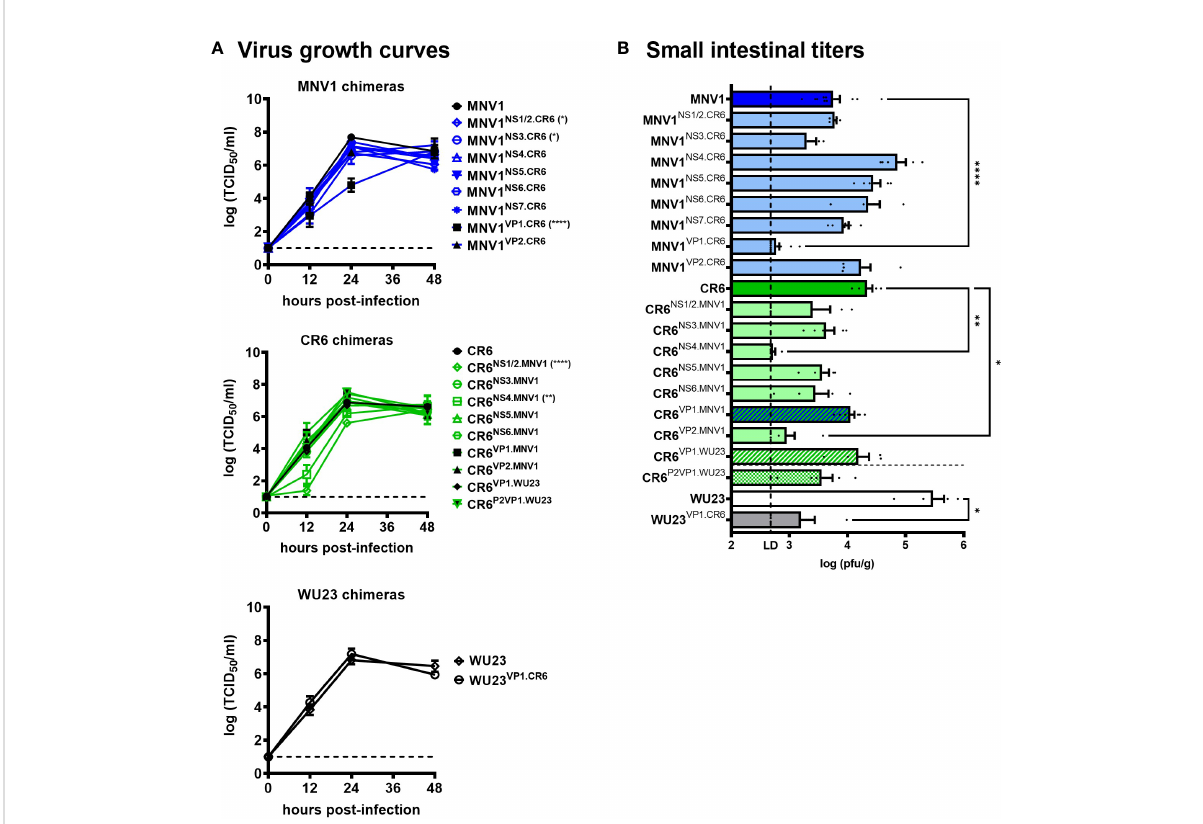
FIGURE 1 Replication ef fi ciency of viral chimeras. (A) Duplicate wells of BV2 cells were infected with MNV1, CR6, WU23 or the indicated chimeric virus at MOI 0.05. Virus titers were determined by TCID 50 assay on culture supernatants. Three independent experiments were performed. P values were determined using ANOVA with Dunnett ’ s multiple comparisons test by comparing each chimeric virus to its respective parental virus. (B) Groups of P3 BALB/c neonatal mice were inoculated with 10 7 TCID 50 units of MNV1, CR6, WU23 or the indicated chimeric virus. At 2d, viral titers were determined in the distal small intestine by plaque assay. At least fi ve mice from at least two independent litters per condition were analyzed. P values were determined using ANOVA with Sidak ’ s multiple comparisons test by comparing each chimeric virus to its respective parental virus. *P < 0.05, **P < 0.01, ****P <